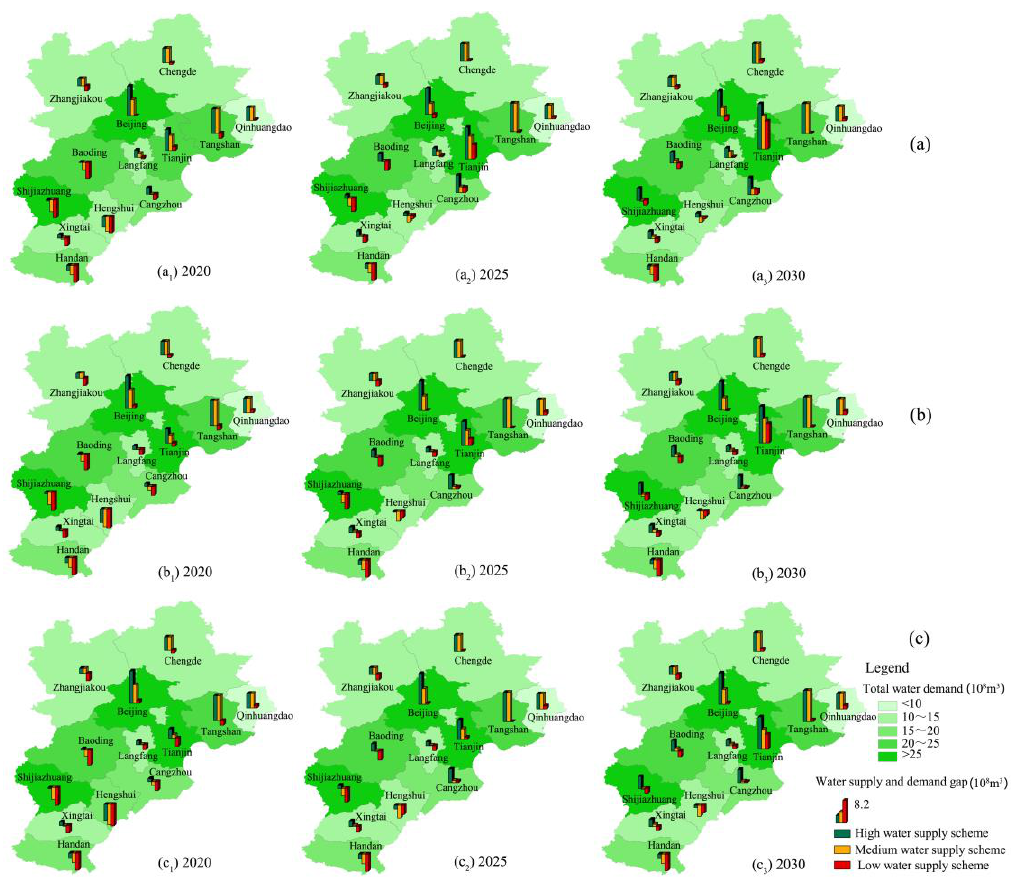
Figure 7. Water supply and demand gap in water-saving mode under different urbanization development scenarios in BTH urban agglomeration. ( a ) Core development mode. ( b ) Subcore development mode. ( c ) Multinode development mode.